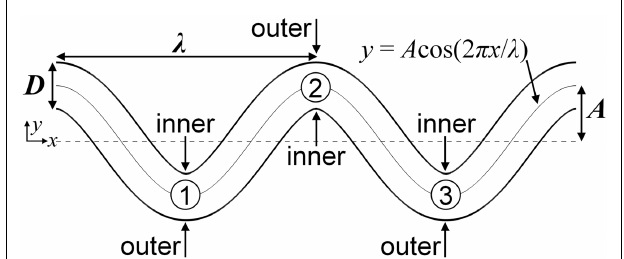
FIGURE 1 | Schematic of the high tortuosity arteriole showing the locations of inner walls, outer walls, and bends, which are labeled numerically